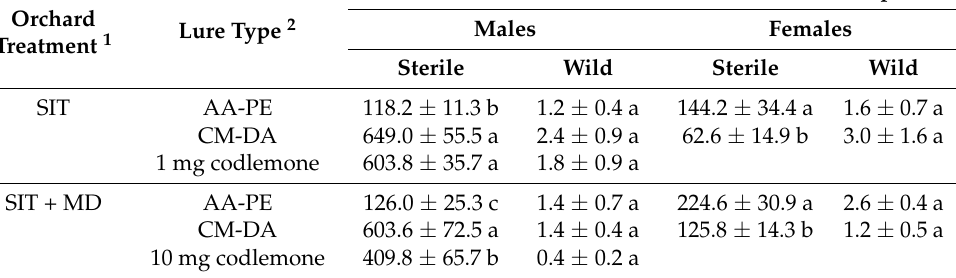
Table 2. Comparative seasonal catches of sterile and wild codling moths in white delta traps baited with various lures in a 17 ha area of apple orchards receiving a sterile insect treatment (SIT) alone, and in an adjacent 12.5 ha area receiving an SIT treatment combined with a pheromone mating-disruption (MD) treatment.